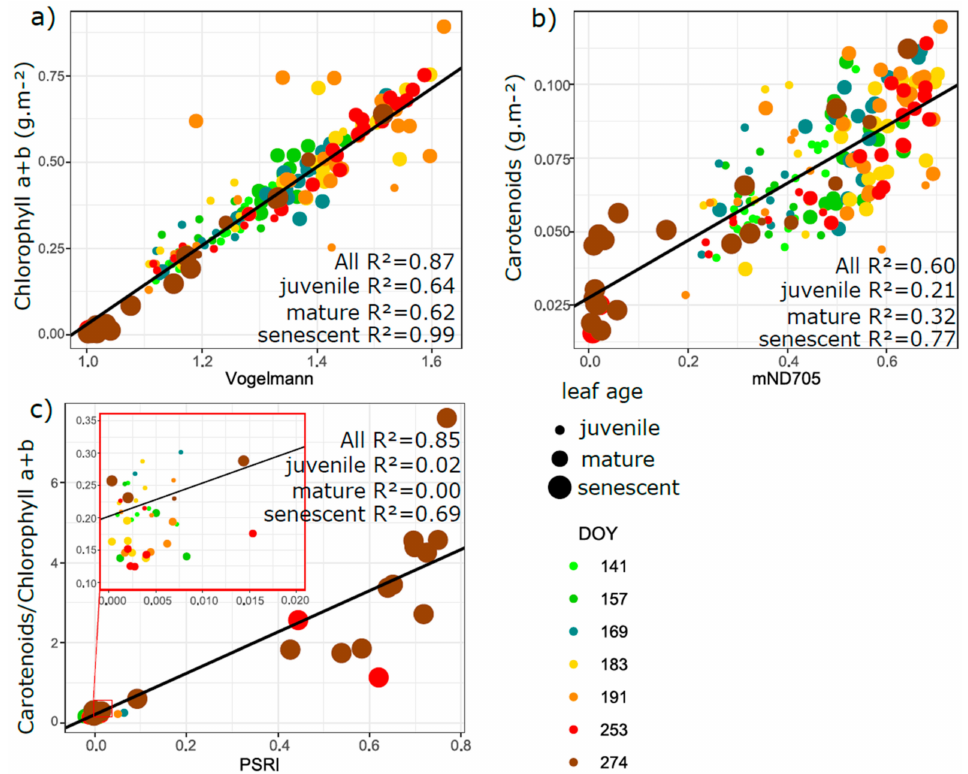
Figure 10. Linear relationship between the best-performing vegetation index and leaf pigment content or their ratio. ( a ) Vogelmann index (R739.5/R719.7) and chlorophyll a + b content; ( b ) mND705 ((R749.9 − R705.1)/(R749.9 + R705.1 − 2*R445.7)) and carotenoids’ content; ( c ) PSRI ((R680.8- R499.6)/R749.9) and carotenoids/chlorophyll ratio, (nested red square = graph, show detail of the main concentration of dots in graph ( c )); different size of circles corresponds to leaf age (juvenile— small, mature—middle, and senescent leaves—large). Different colors correspond to individual DOYs during the season. R 2 : coefficient of determination is shown for all leaf developmental stages pooled together (All); juvenile, mature, and senescent leaves